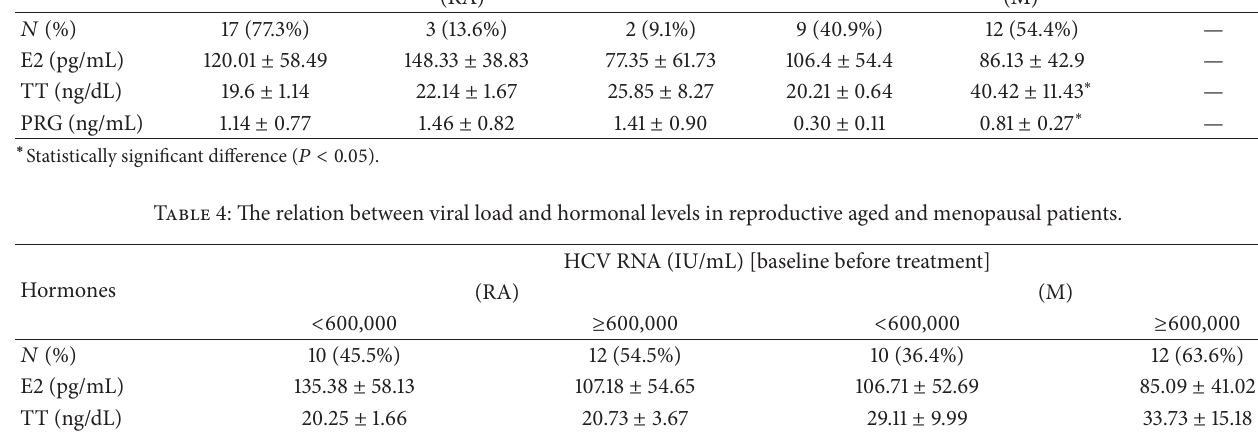
Table 3: The relation between virological response and hormonal levels in reproductive aged and menopausal patients. Hormones